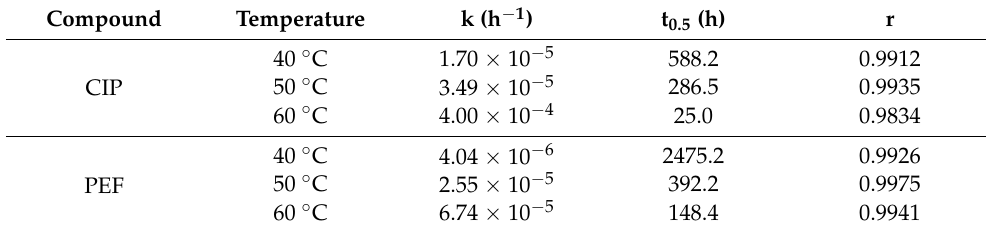
Table 3. The kinetic results of the CIP and PEF oxidation by ACVA.